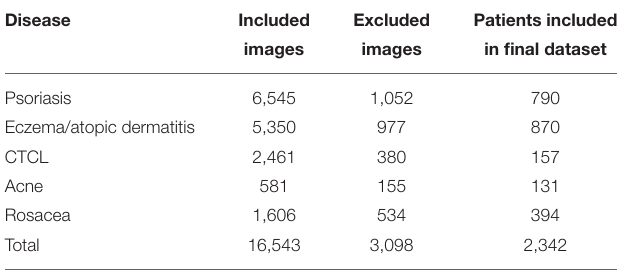
TABLE 1 | Data distribution in disease category. Disease